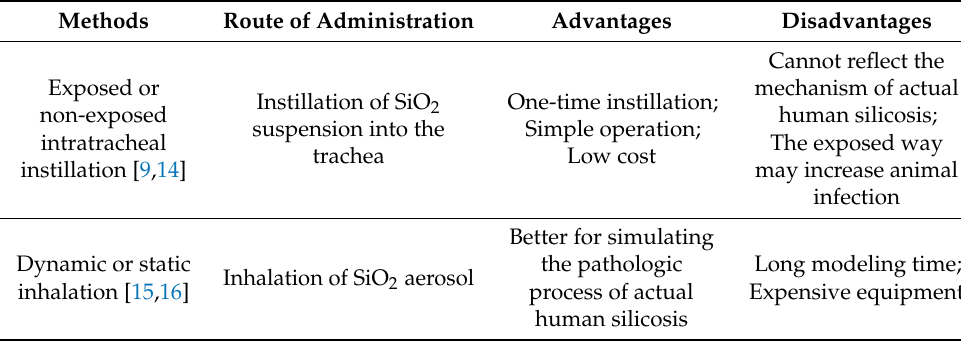
Table 1. Comparison of different silica-induced mice or rat silicosis